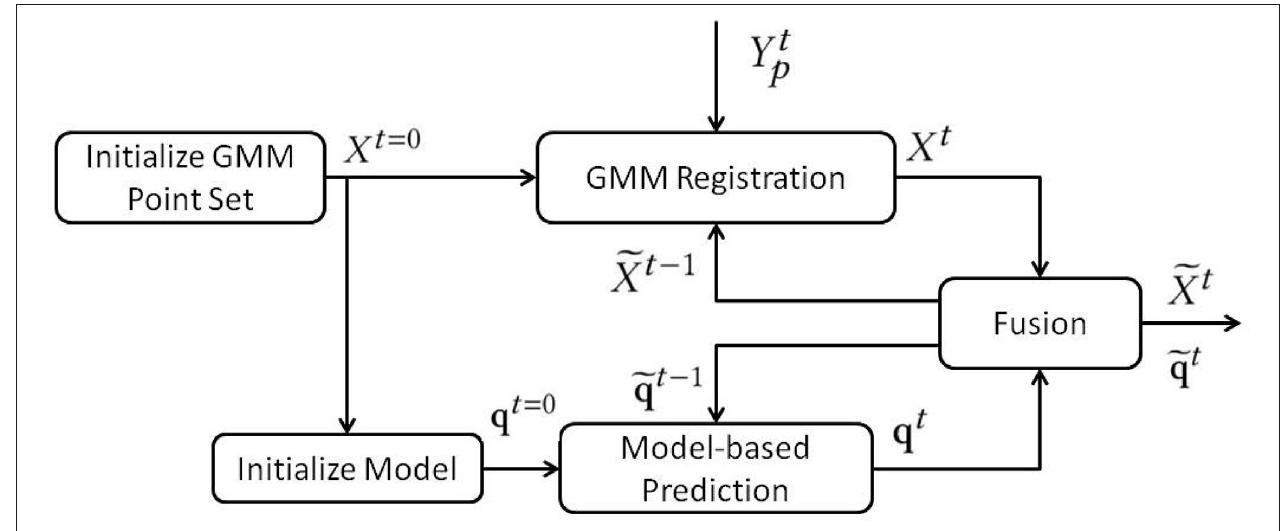
FIGURE 4 | The framework of the state estimator for